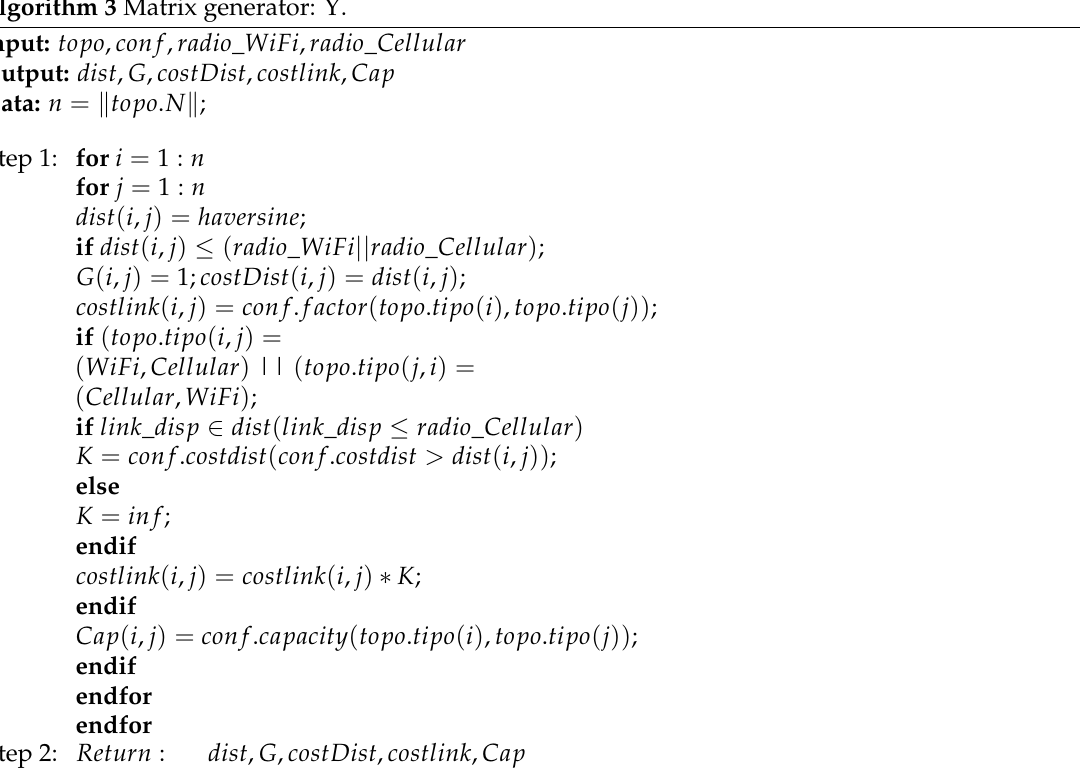
Algorithm 3 Matrix generator: Υ